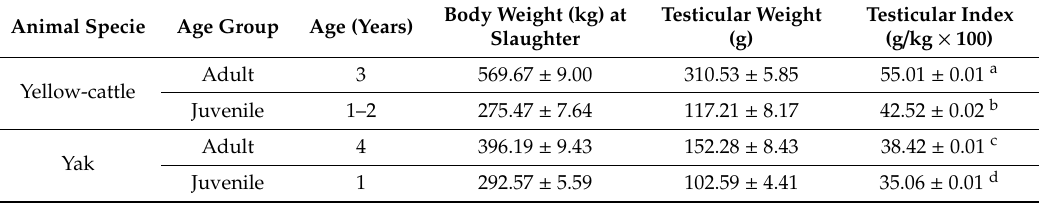
Body Weight (kg) at Testicular Weight Testicular Index Slaughter (g) (g / kg × 100)